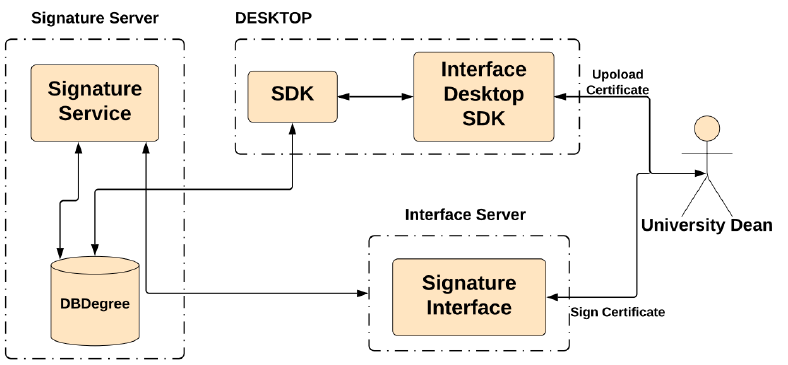
Figure 3. Digital signature